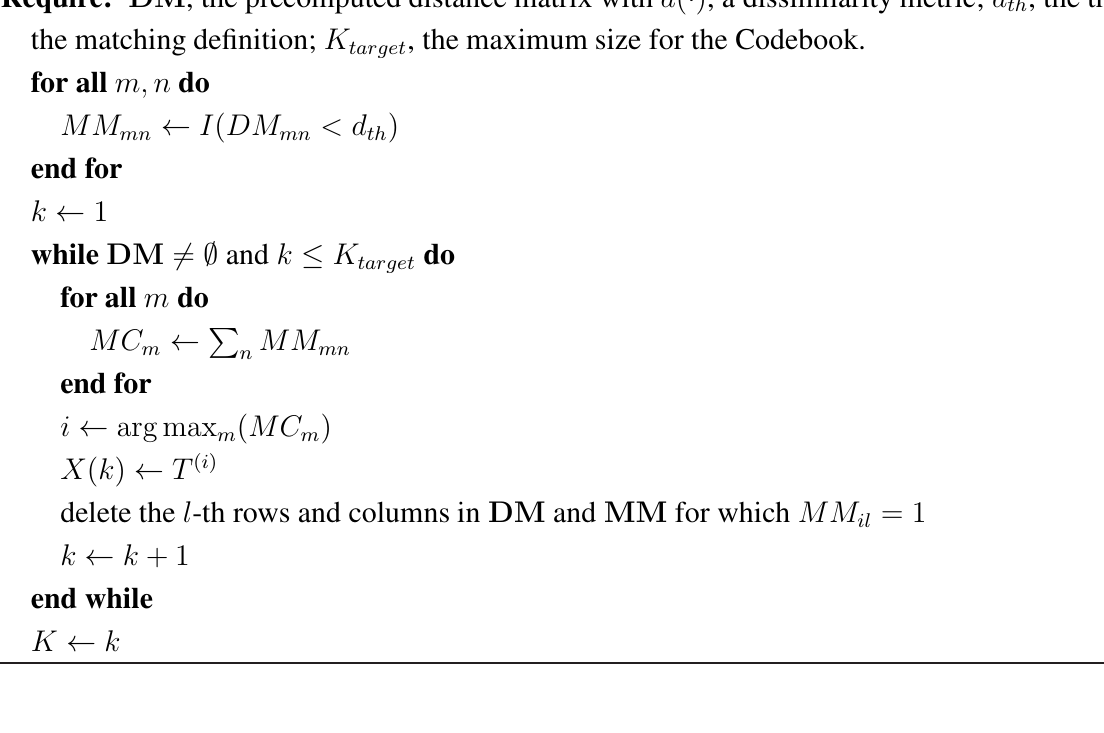
Algorithm 1 Matching-Basedmotif extraction algorithm.